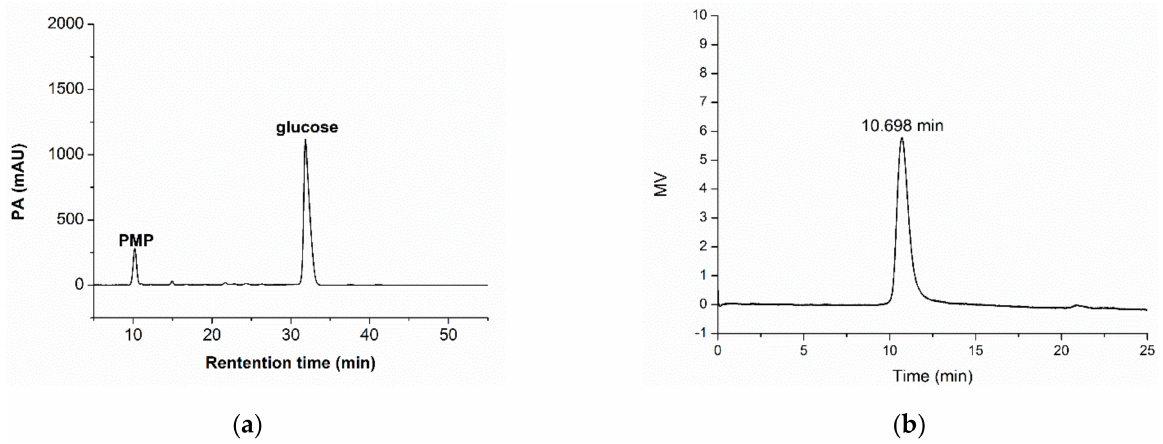
Figure 2. Monosaccharide composition ( a ) and molecular weight ( b ) of the purified